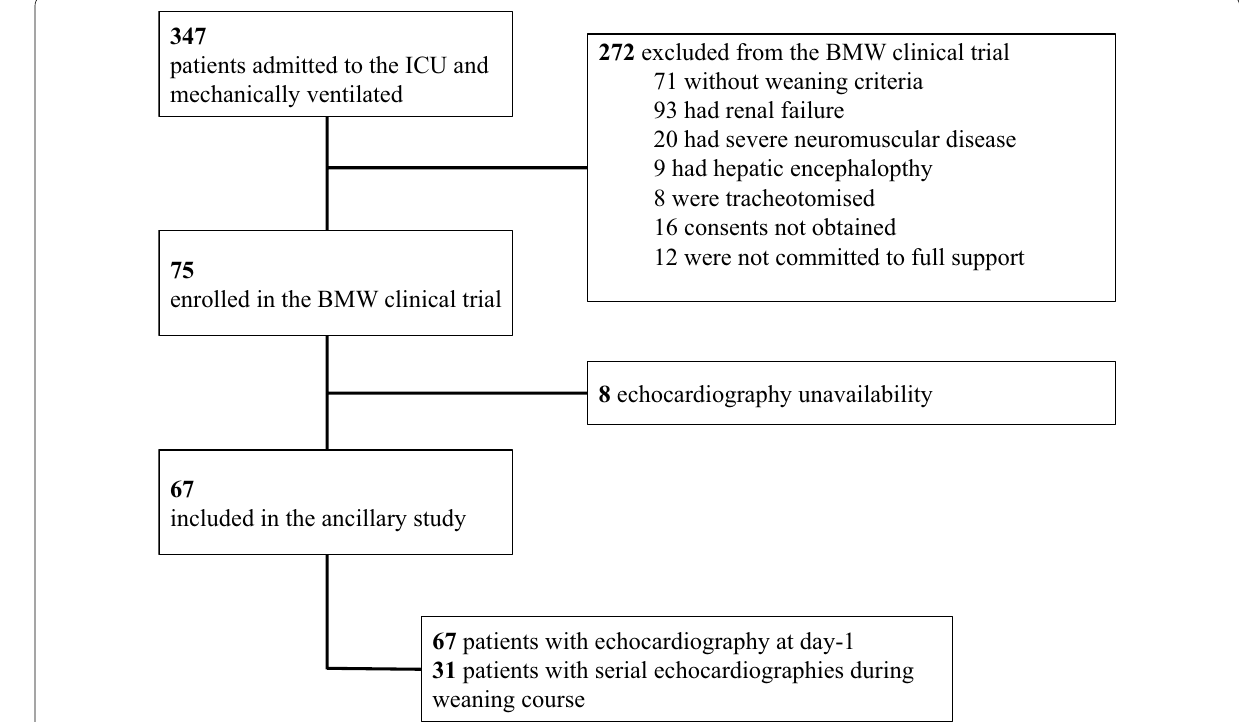
Fig. 1 Study flow chart. BMW B‑type natriuretic peptide for the fluid management of